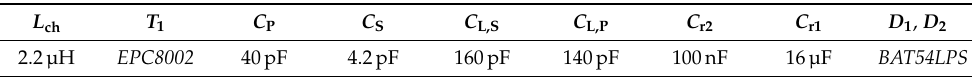
Table 2. Components and component values of the applied RF power electronics. C L,P is reduced by 20pF from the value in Section 2.1 to compensate for the input capacitance of the rectifier.